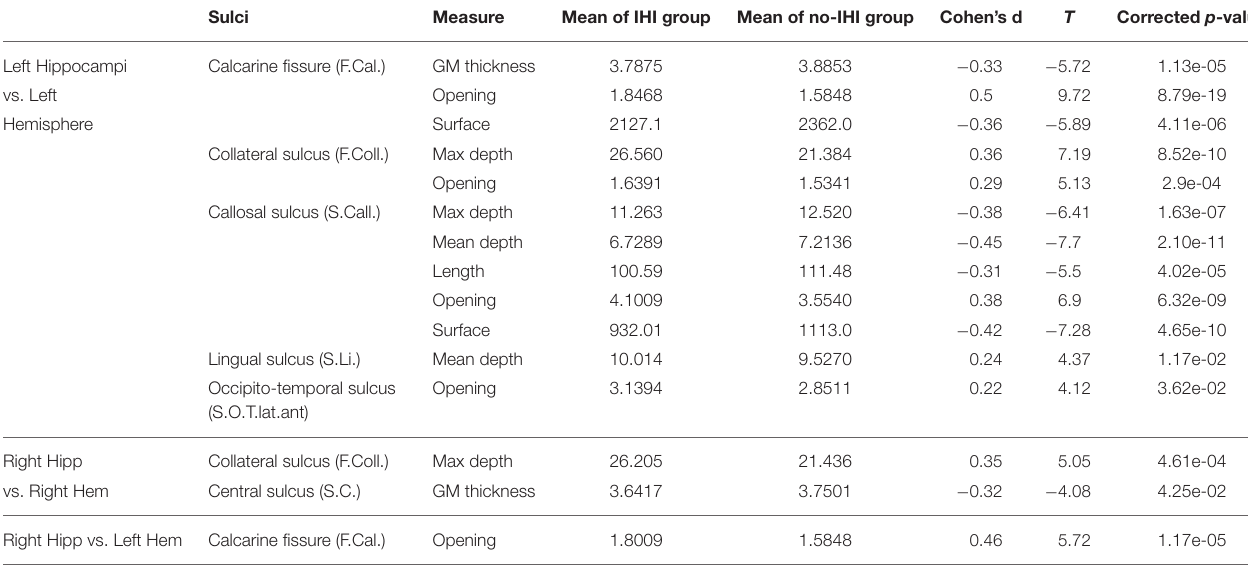
Right Hipp Collateral sulcus (F.Coll.) vs. Right Hem Central sulcus (S.C.) GM thickness Right Hipp vs. Left Hem Calcarine fissure (F.Cal.)